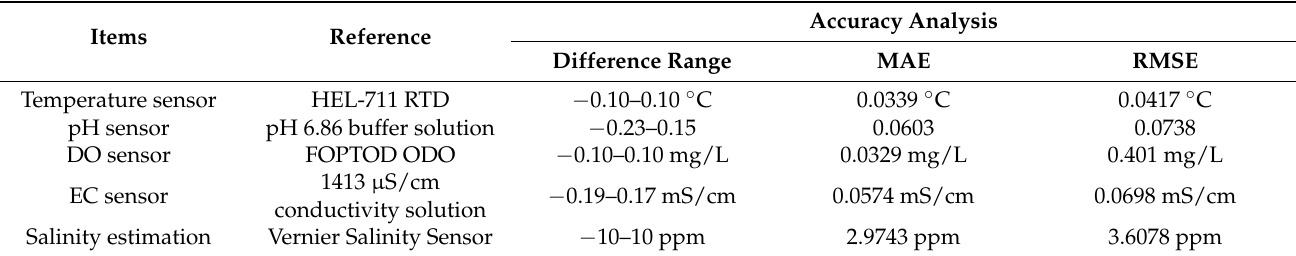
Table 7. Accuracy analysis of water temperature, pH, DO, and EC, and salinity levels for